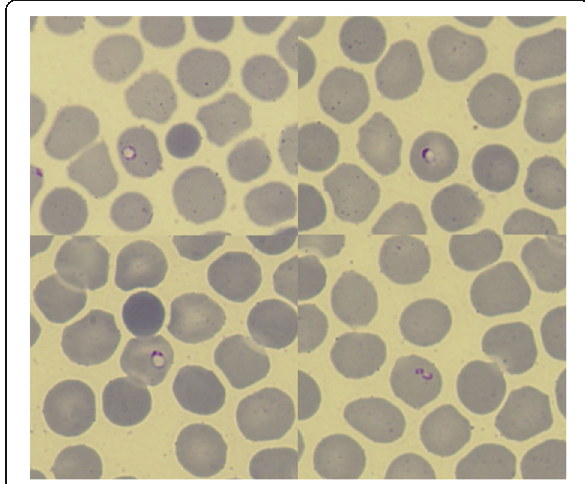
Fig. 1 Blood smear of the patient at presentation. Photomicrograph of the blood smear shows ring forms of Plasmodium falciparum (×1000 magnification; Giemsa